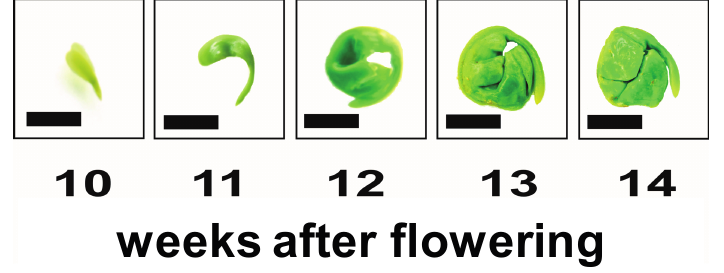
Figure 1. Embryogenesis of A. platanoides L. from 10 through 14 weeks after flowering (WAF). Bar = 5